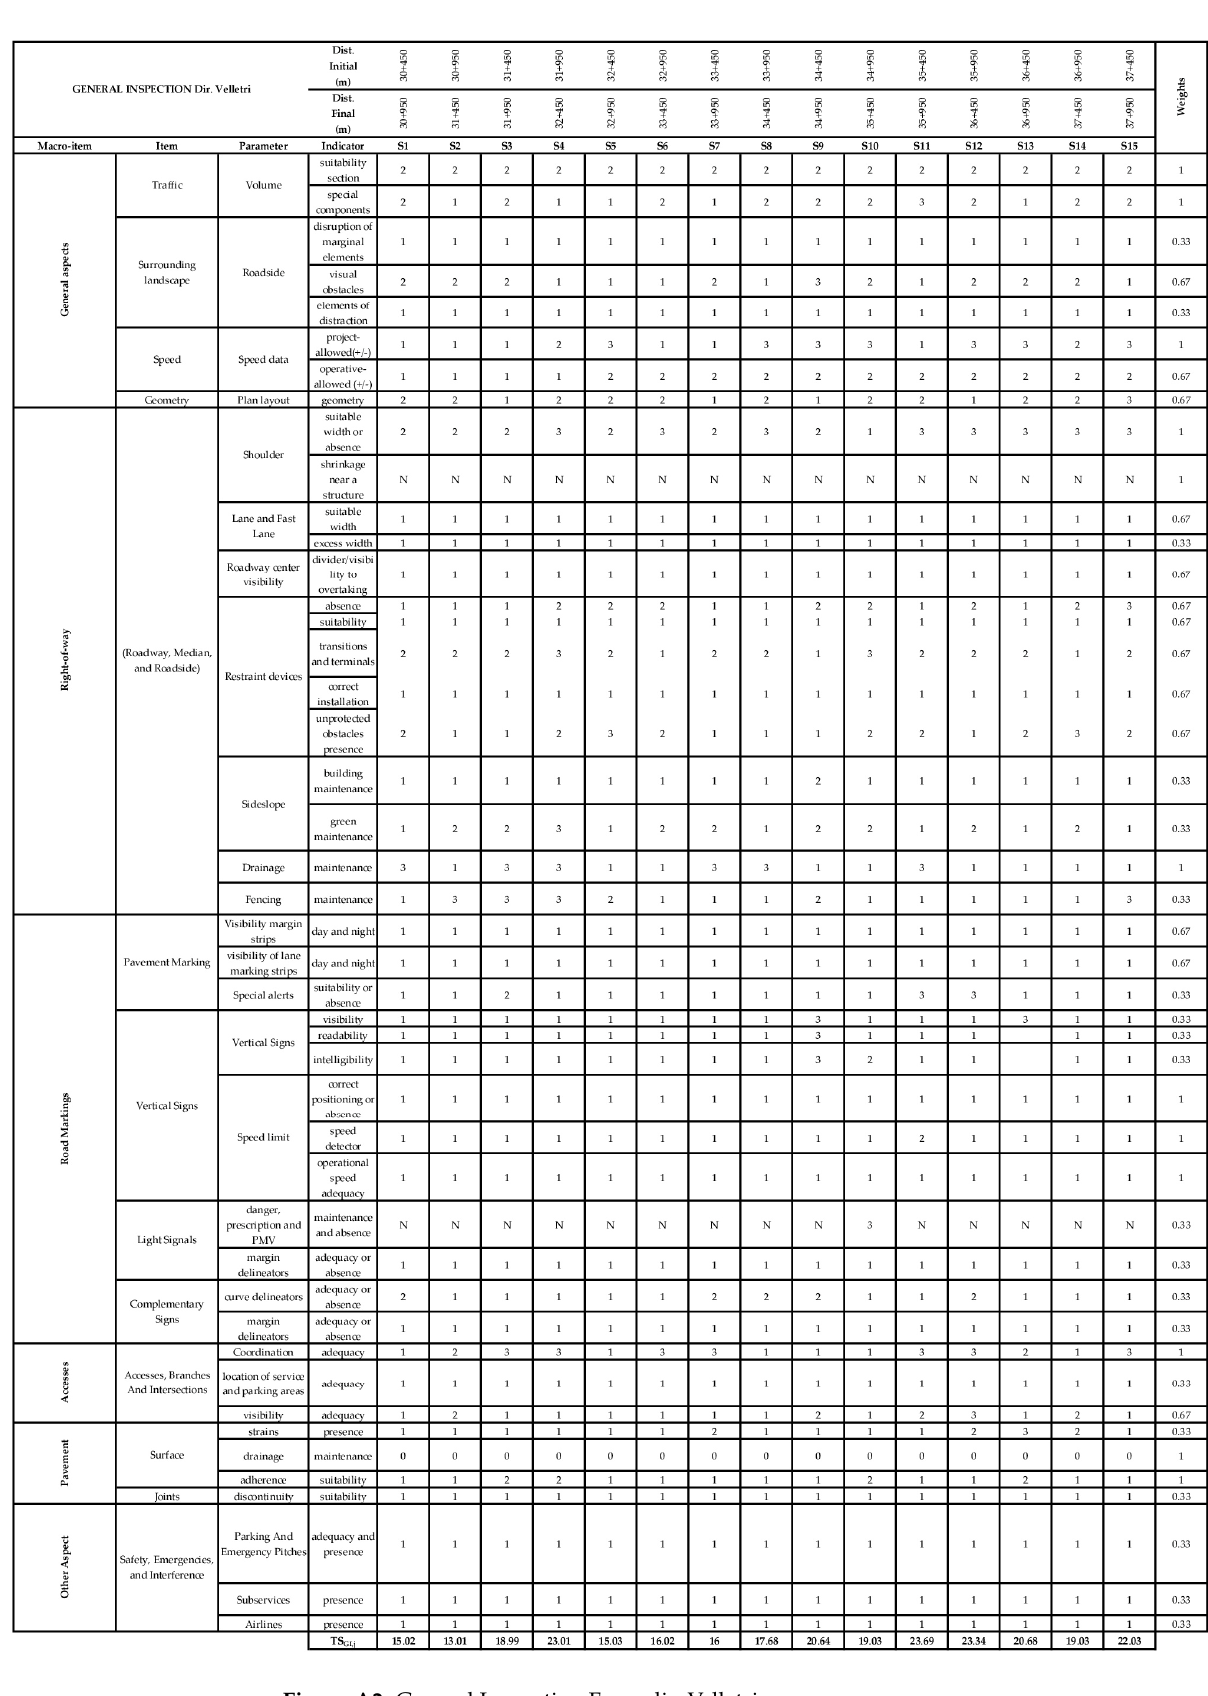
Figure A2. General Inspection Form dir. Velletri.